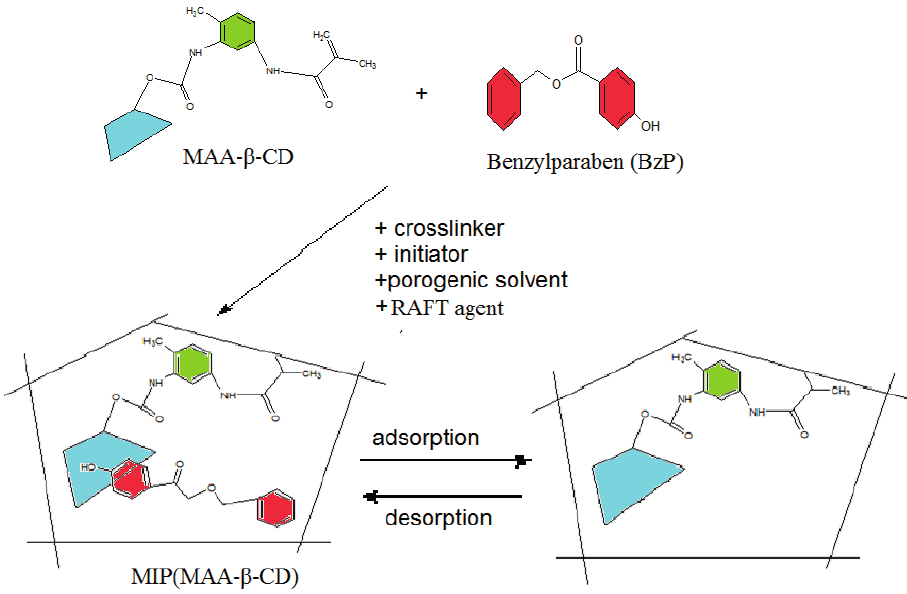
Scheme 3. Preparation of molecularly imprinted polymer-methacrylic acid functionalized β -cyclodextrin, MIP(MAA- β